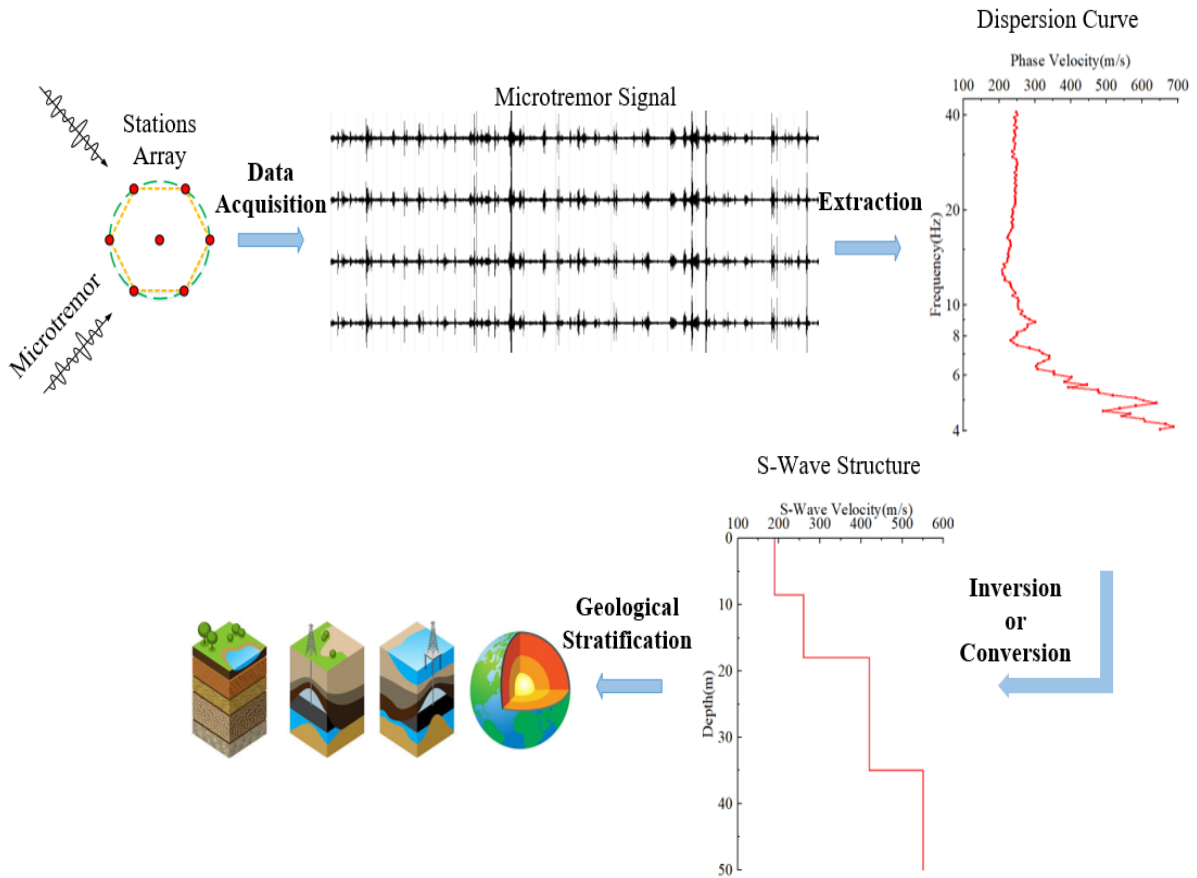
Figure 1. Flowchart of microtremor survey.